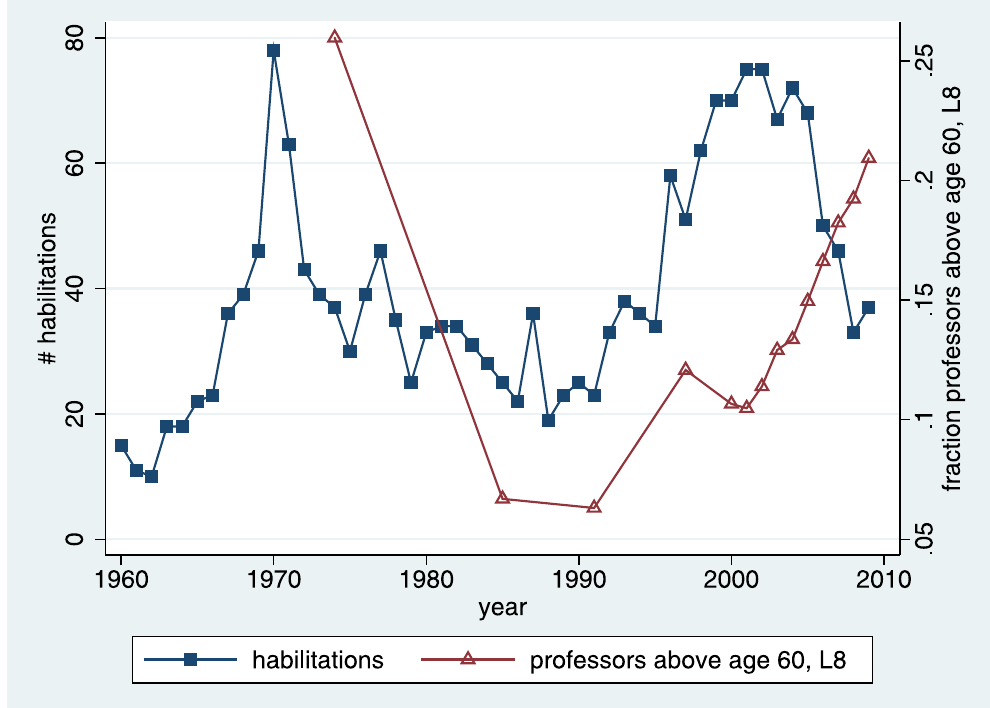
Fig 10. Expected Number of Available Positions.